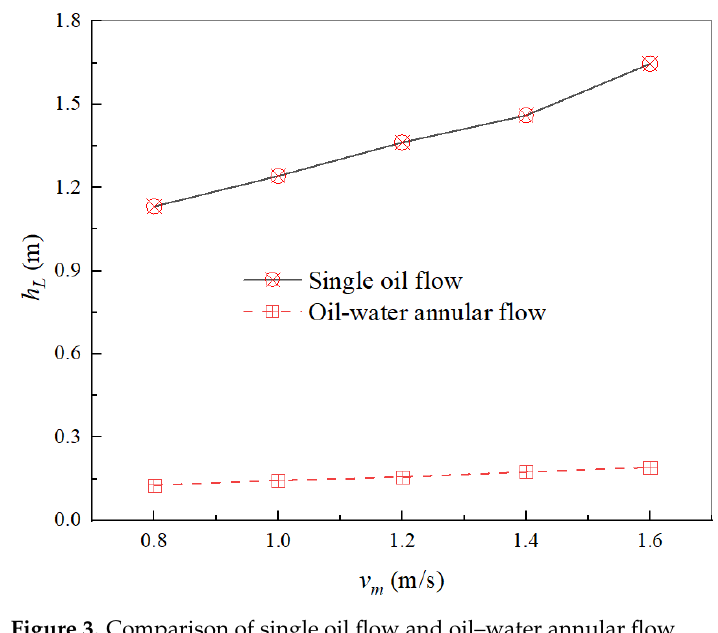
Figure 3. Comparison of single oil flow and oil–water annular flow.